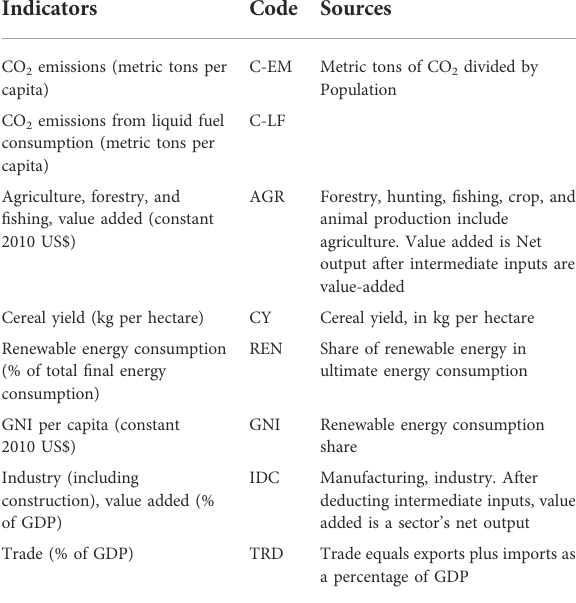
TABLE 1 Indicator de fi